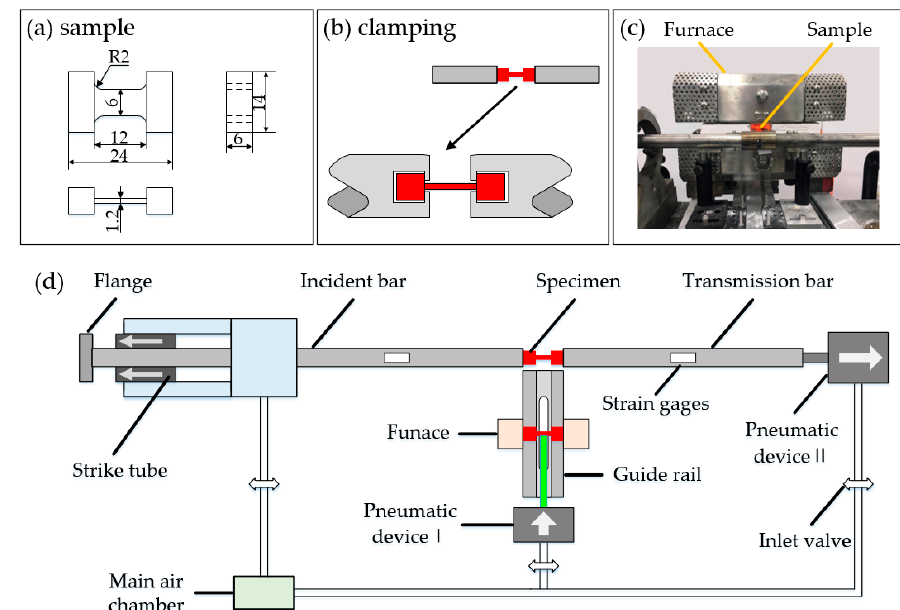
Figure 3. SHTB technique at high temperature with a double pneumatic device. ( a ) Samples used in the tests; ( b ) clamping device; ( c ) the real SHTB device used; ( d ) experimental device schematic.